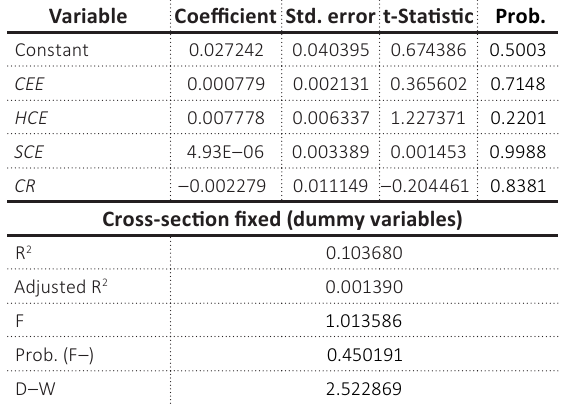
Table 12. Random effects for model 2